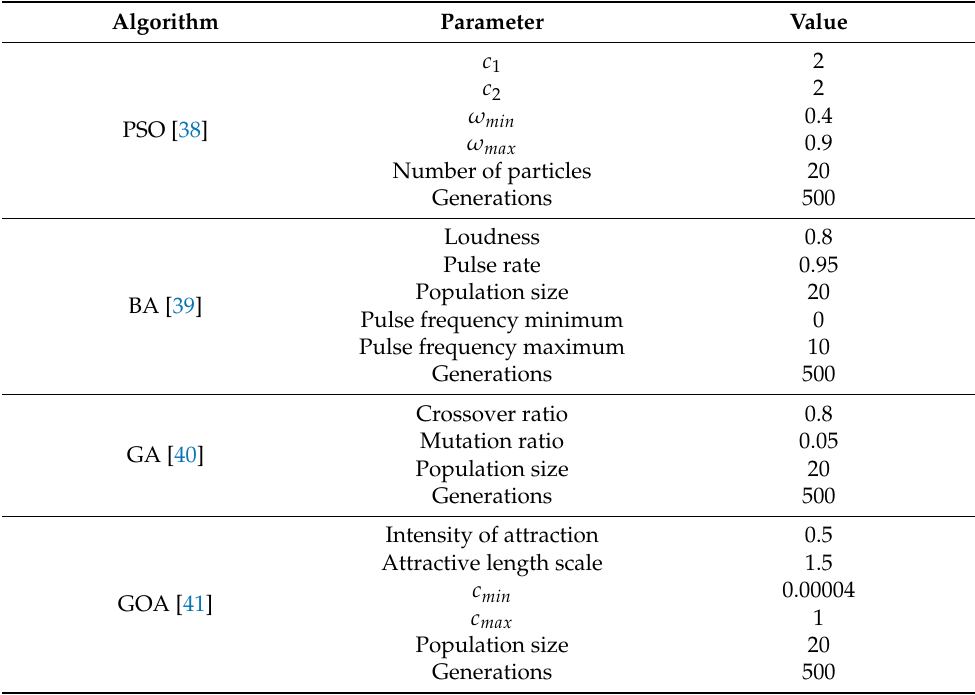
Table A1. Initial parameters of the PSO, BA, GA, and